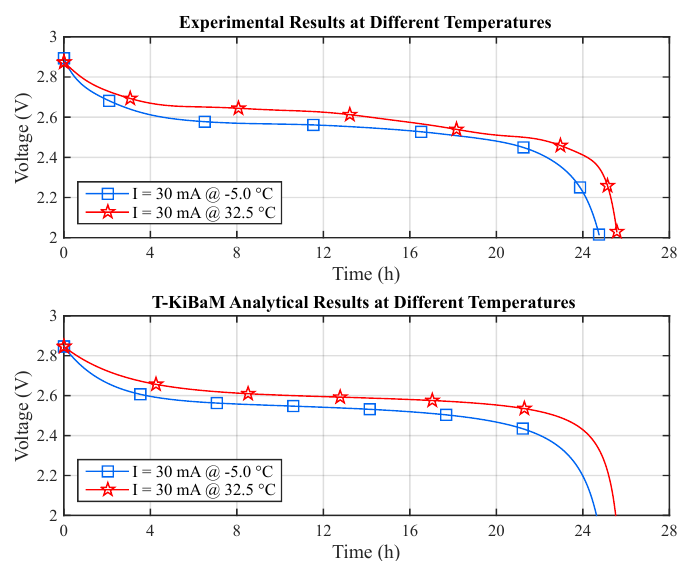
Figure 10. Experimental vs. T-KiBaM analytical comparison at different temperatures.